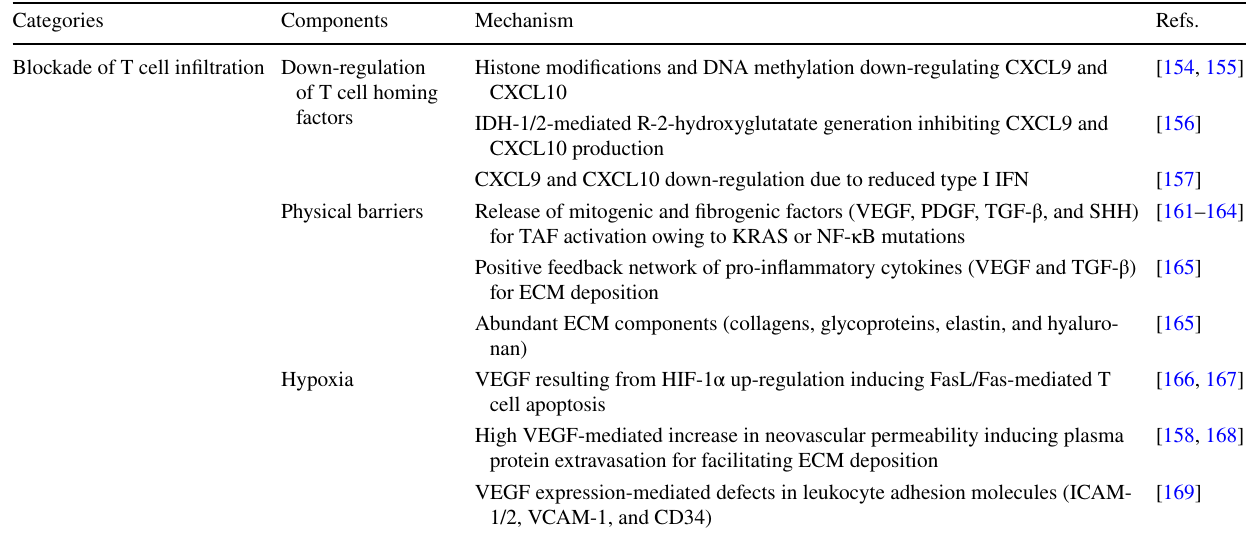
Table 3 Characteristics of T cell exclusion in cold tumors